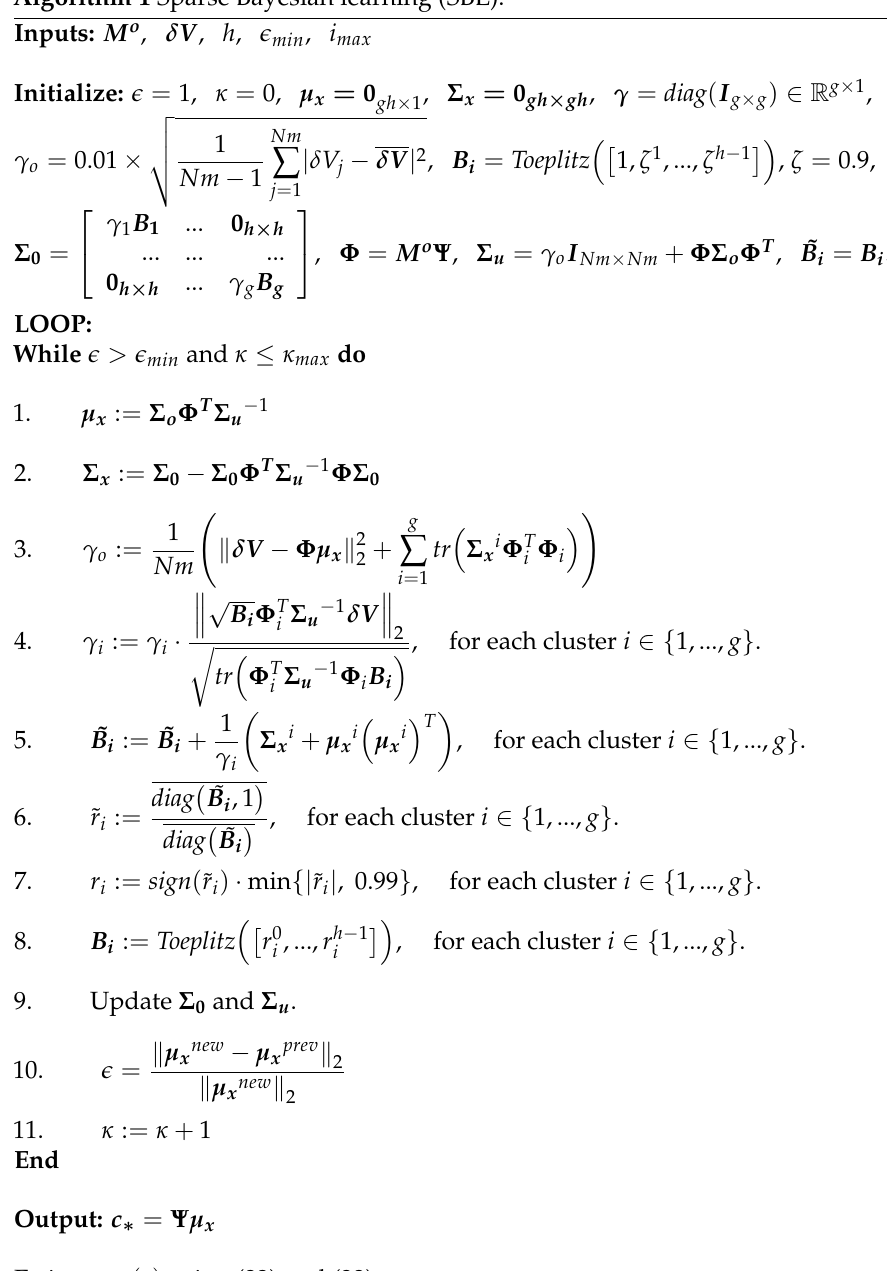
Algorithm 1 Sparse Bayesian learning